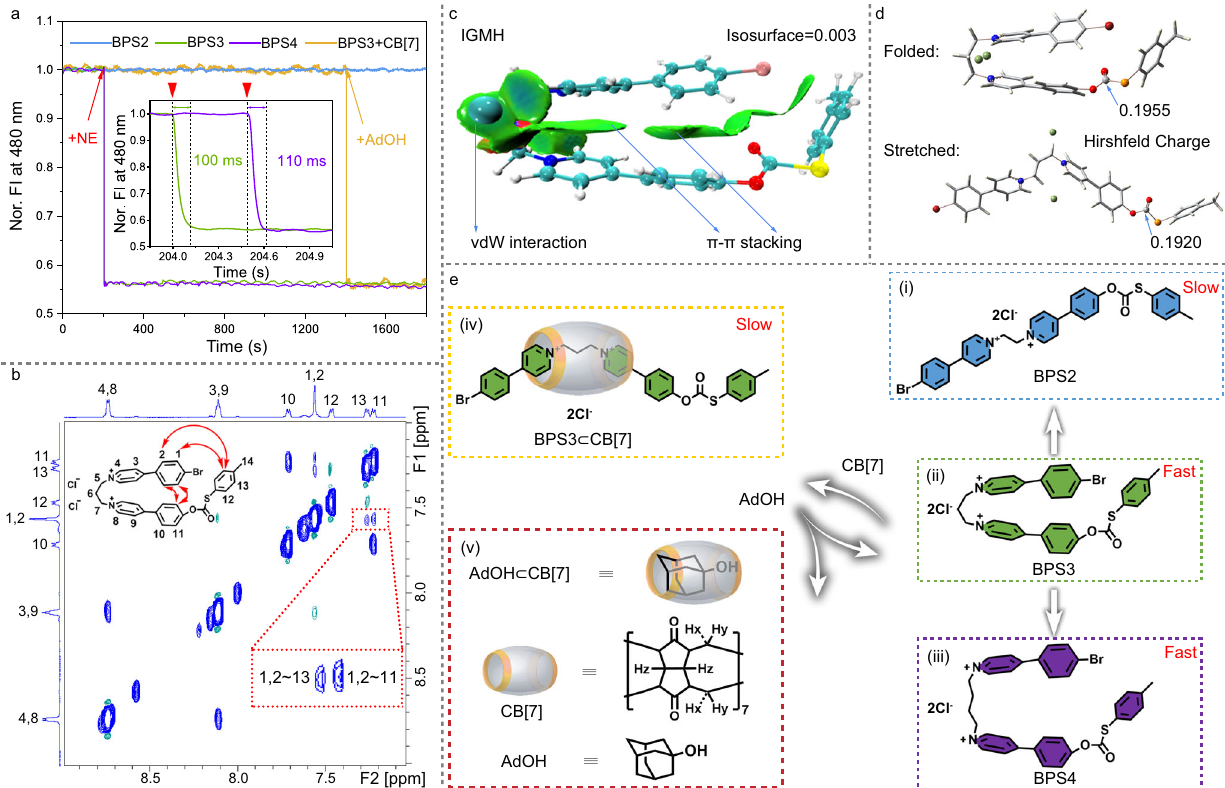
Fig.3|Conformation-dependentreactionkineticsforNEsensing.a Normalized fl uorescence response dynamics (recorded at 480nm, excited at 720nm) of 5 μ M aqueous solution of BPS2, BPS3, BPS4, and BPS3+CB[7] (1equiv.)with addition of 100nMNE.ForthecurveBPS3+CB[7],anadditional1equiv.ofAdOHwasaddedat thetimeof1200saftertheadditionofNE.Inset:Enlargedviewofthepartialcurve